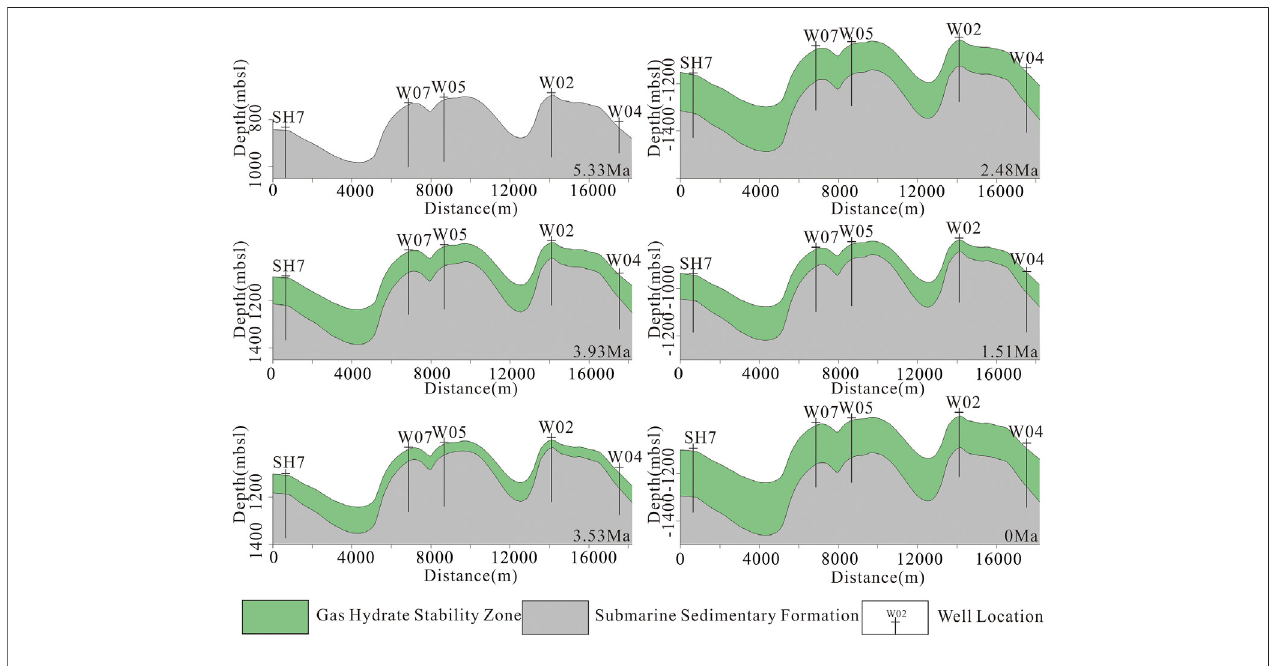
FIGURE 4 | Thickness variation in the GHSZ in Section 1 since 5.33